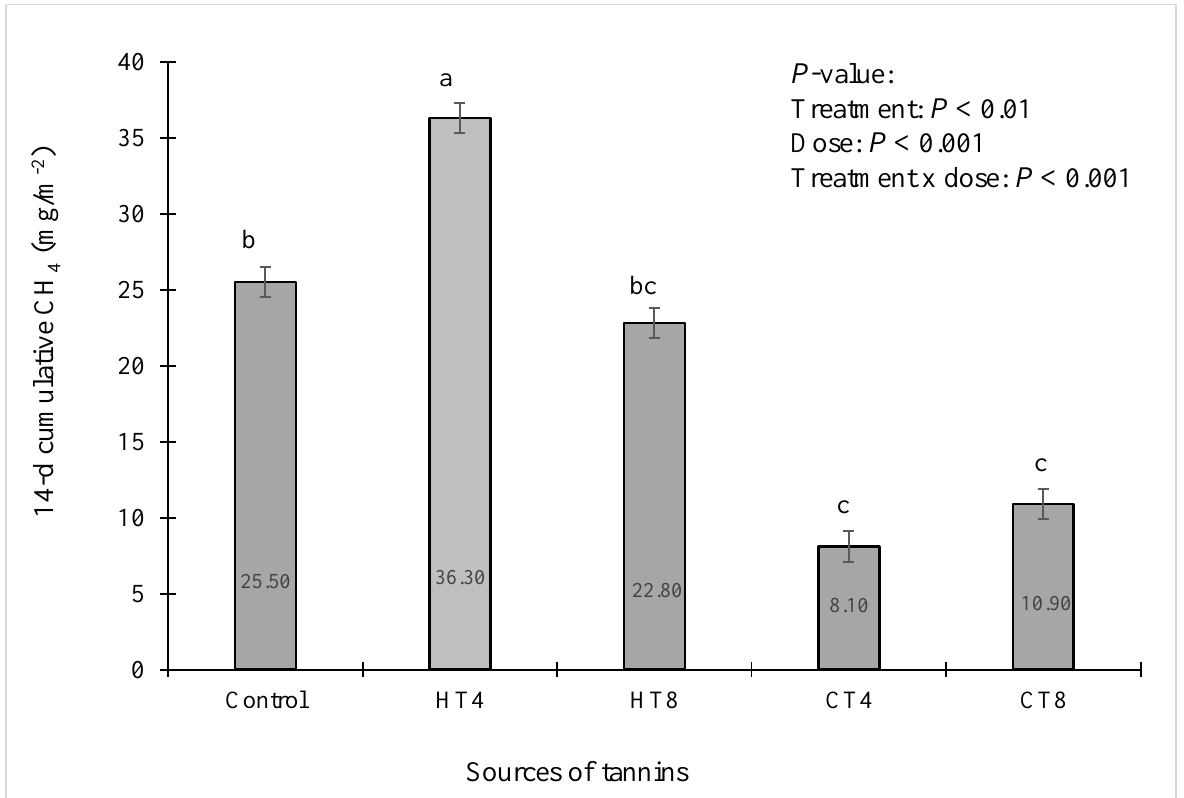
Figure 3. The effect of sources of tannins on cumulative CH 4 emissions from in vitro incubation with dairy cattle manure for 14 d. Data show means ( n = 3), numbers in a row followed by different lowercase letters ( a–c ) indicate treatment effect ( p < 0.05–0.001). CT = quebracho condensed tannins (4% and 8%); HT = chestnut hydrolysable tannins (4% and 8%). Error bars represent the standard error of the means.